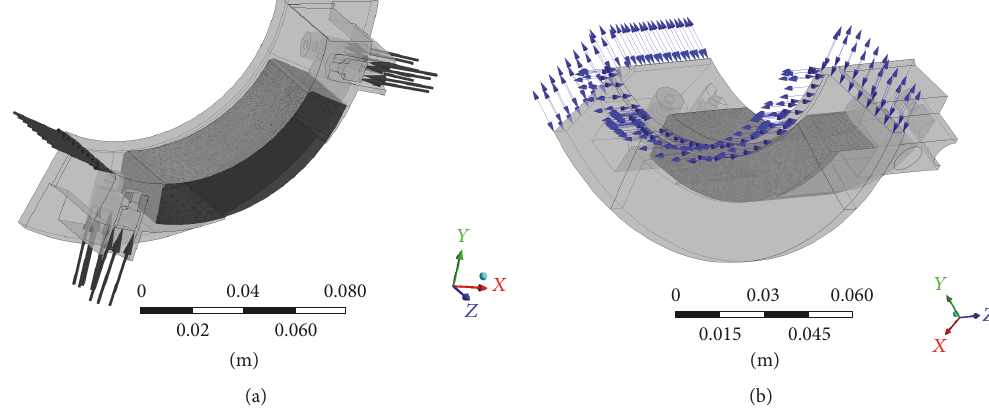
Figure 5: Inlet (a) and outlet (b) boundary conditions for CFD analyses.